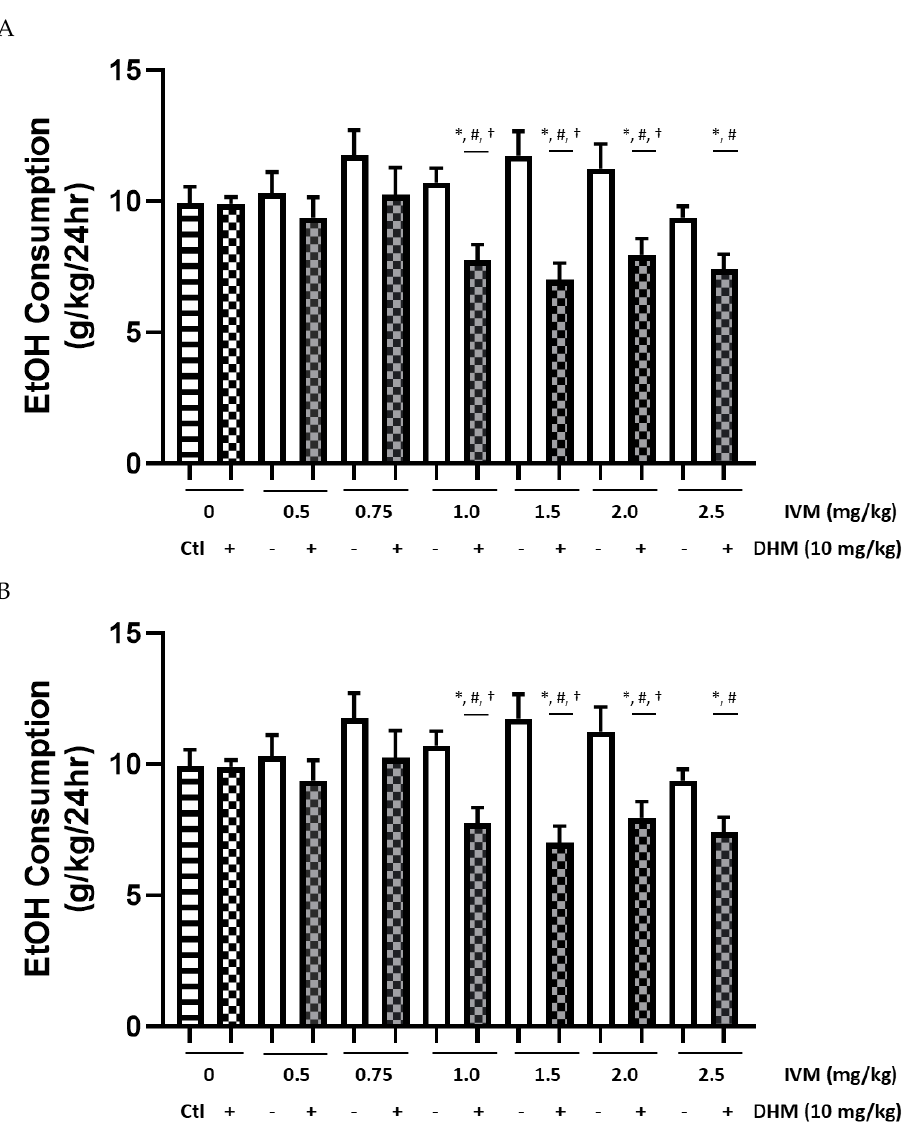
Figure 2. DHM (10 mg/kg) combined with IVM reduces the dosing necessary to significantly